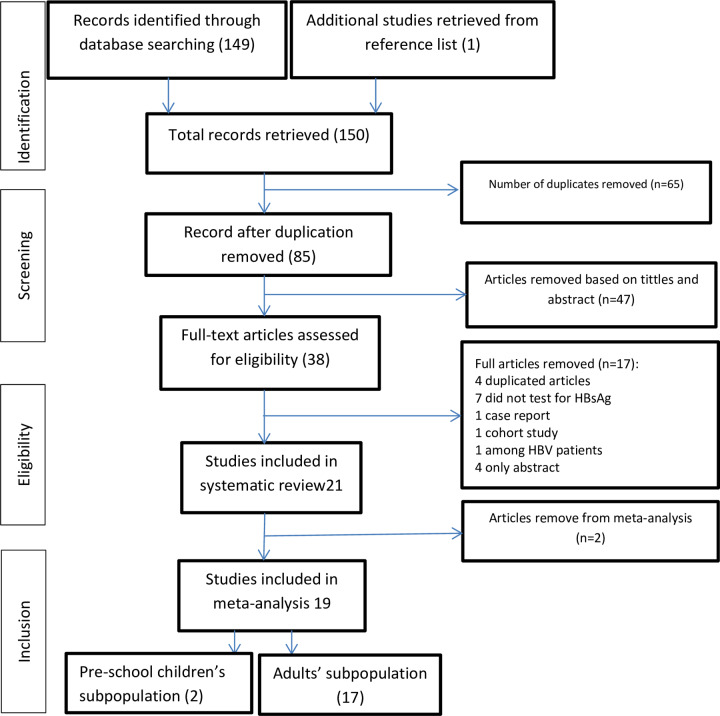
Flow chart of study search and retrieval process (adopted PRISMA: 2009).